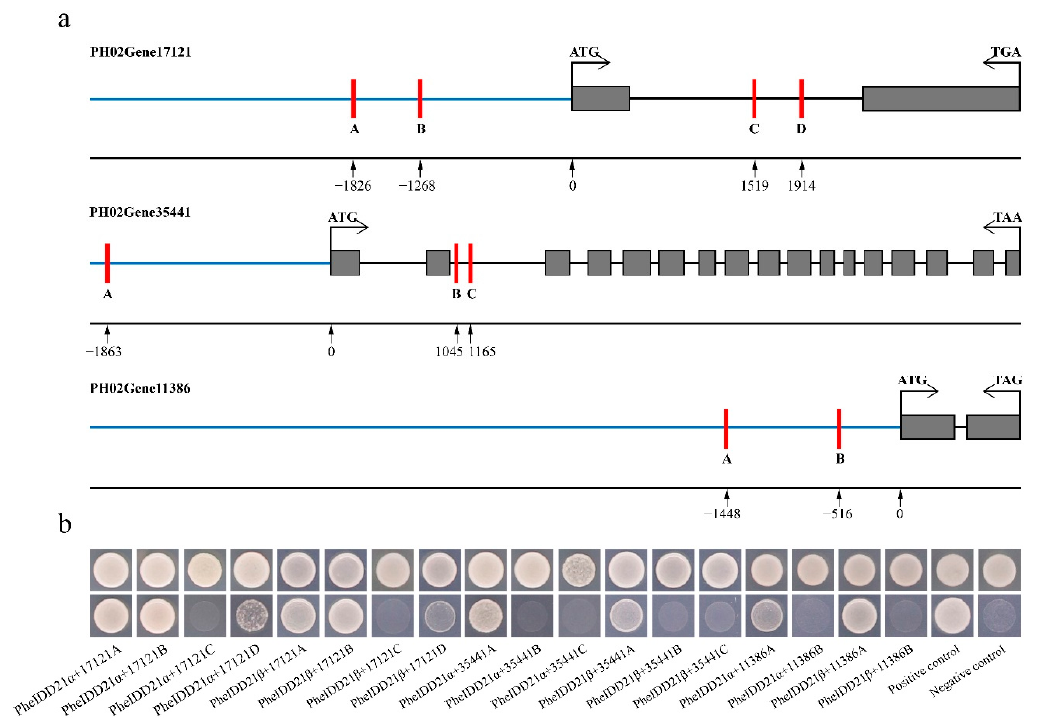
Figure 11. PheIDD21 directly binds to three genes (PH02Gene17121, PH02Gene35441, and PH02Gene11386). ( a ) Schematic diagram of putative cis -elements in the three genes, which were used for PheIDD21 binding assays. The capital letters A–D indicate the locations of the cis -elements. ( b ) Yeast one-hybrid assays showed binding of PheIDD21 α / β to the putative cis